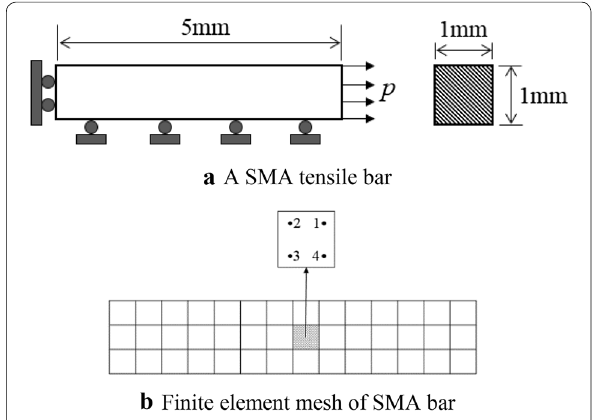
Figure 2 A SMA tensile bar and its finite element mesh